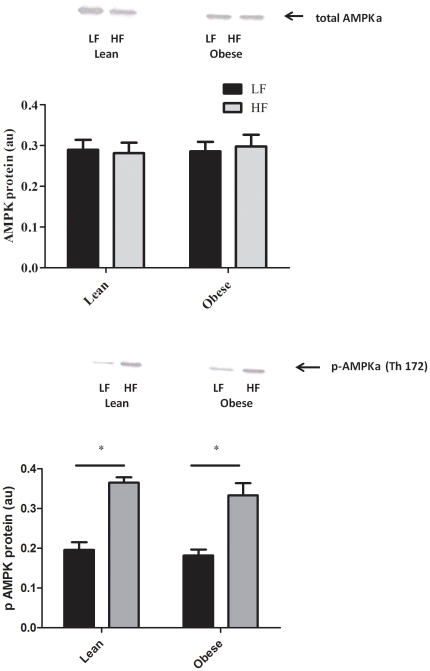
Mean (± SE) total (Top) and phosphorylated (Bottom) AMPK protein during LF (black bars) and HF (grey bars) in LN (N = 5) and OB (N = 6).Representative blots are show above the graphs. * LF significantly different from HF (P<0.05).